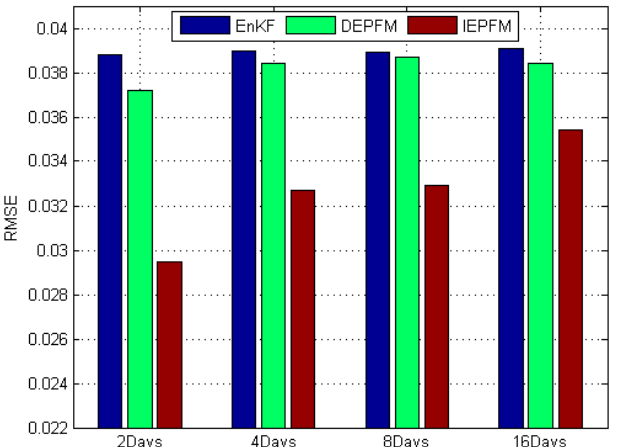
Figure 10. Bar plots of the RMSEs obtained by three methods with the same parameters and different assimilation frequencies.